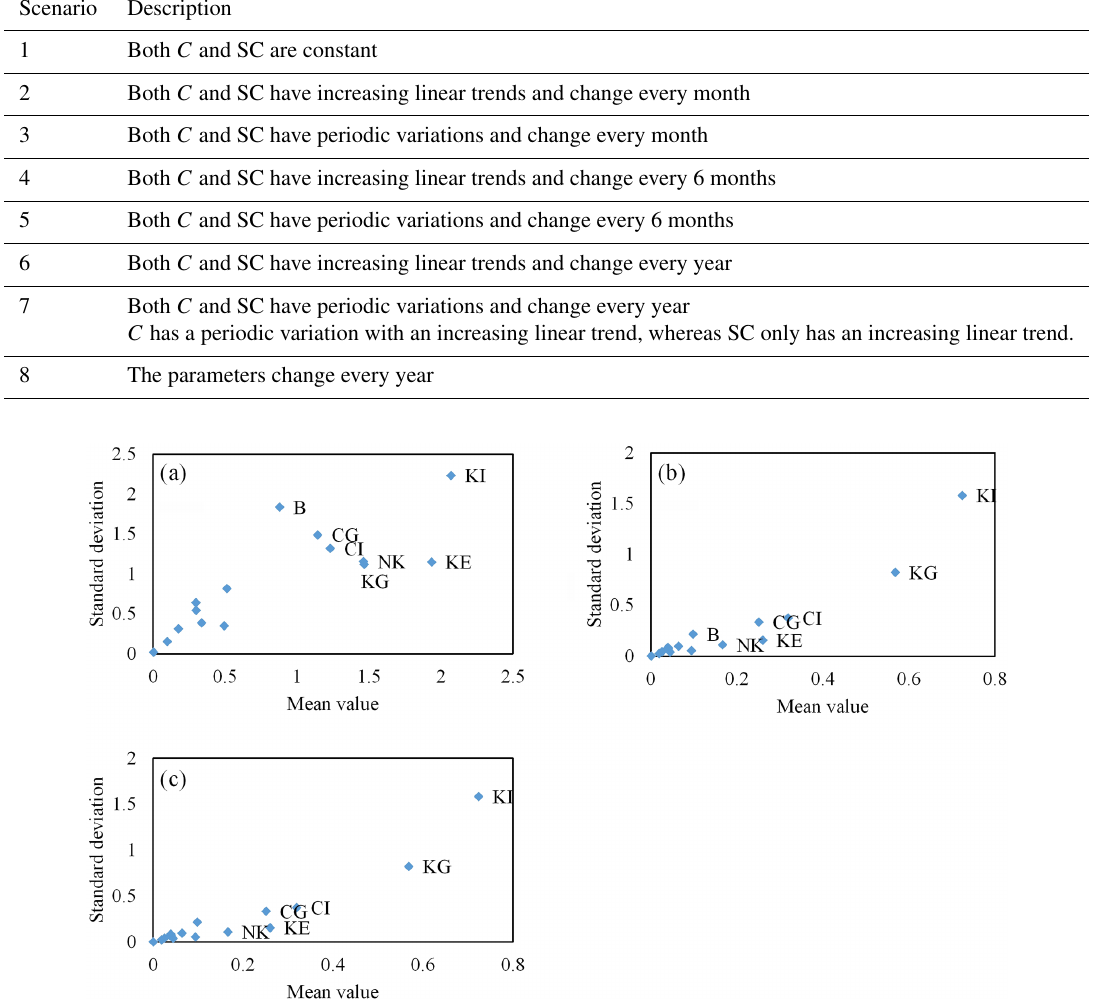
Figure 4. Results of the Morris method for the synthetic experiment with the Xinanjiang model. The sensitivity analysis is based on three different kinds of model responses: (a) NSE, (b) NSE abs , (c) NSE ln . Only the most sensitive parameters are